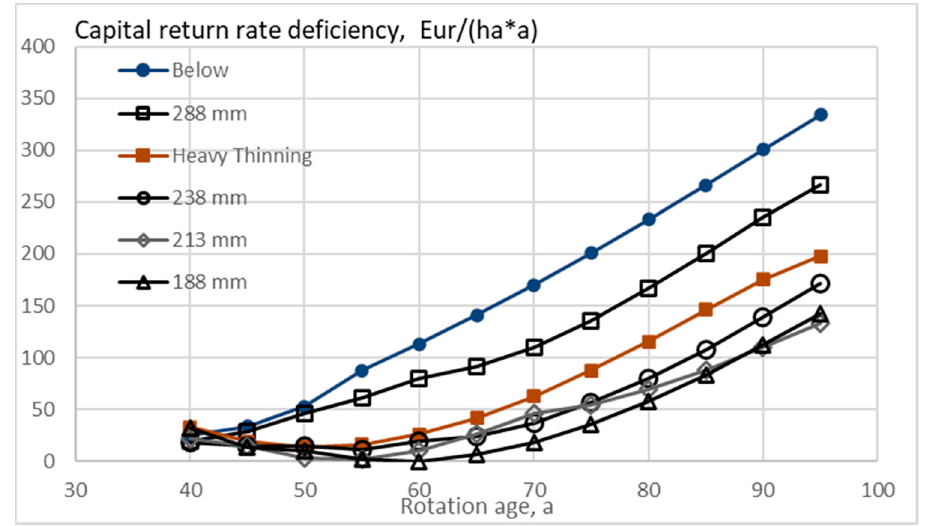
Figure 11. The deficiency of the expected value of capital return rate in terms of Euros per hectare and year. The deficiency is plotted for six different treatment schedules and any rotation age.